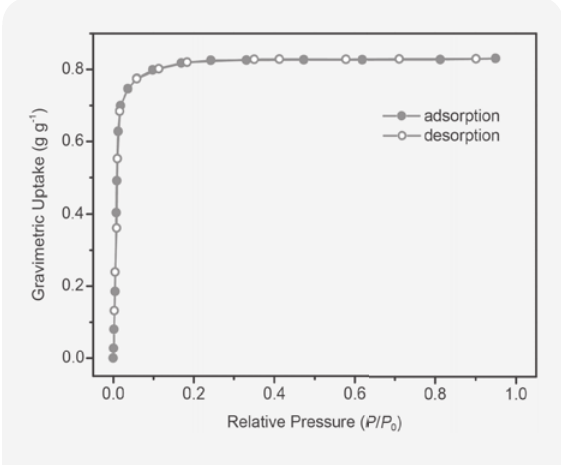
Fig. 2b. N 2 adsorption isotherm of MOF-5 (77 K) revealing its ultra- high